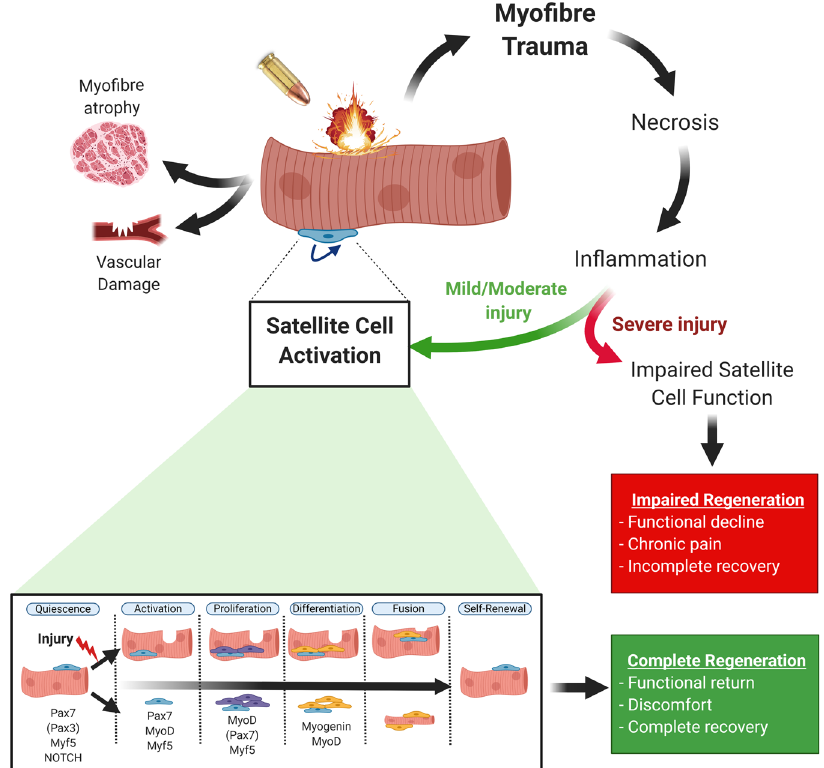
Fig. 2 Overview of the mechanisms involved in the muscle injury-regeneration response following projectile trauma. Ballistic trauma would induce immediate myo fi ber trauma, alongside secondary atrophy and vascular damage. Myo fi bre trauma initiates a chain of events, including necrosis and in fl ammation, which then activates satellite cells to aid muscle regeneration. Satellite cells progress through a well- established cycle of events, starting from activation and ending with fusion, which is tightly controlled by numerous transcription factors (bottom panel; e.g., Pax7, MyoD) 73 . Patients that suffer mild to moderate muscle damage have a high chance of complete recovery, due to the muscle regeneration process proceeding as normal. In contrast, patients with a severe muscle injury will show impaired recovery, due to extensive loss of muscle tissue and impaired satellite cell function that inhibits muscle regeneration with chronic pain and fi brosis. Secondary atrophy and vascular damage can also contribute to impaired muscle regeneration via inhibiting normal satellite cell function. Bottom panel is adapted from Baghdadi and Tajbakhsh 73